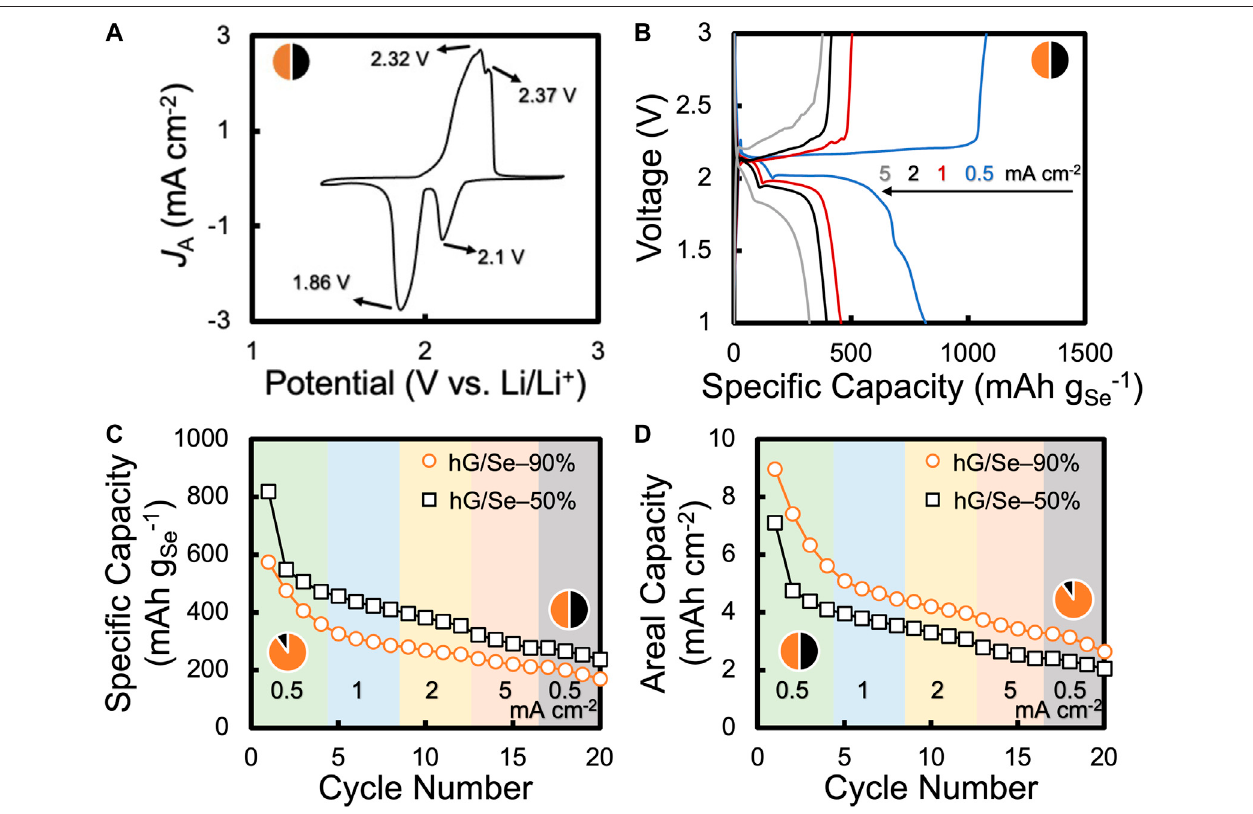
FIGURE3| ElectrochemicalperformanceofLi-SebatterycellswithhG/Secathodes: (A) CVofacellwithahG/Se-50%cathodeat0.05 mV s − 1 ; (B) dischargeand charge curves ofa cell sequentially cycled at 0.5, 1,2, and 5 mA cm − 2 (each for 4cycles); curvesshown arethe fi rst cycle ofeach J A segment, and comparisons ofcells with a hG/Se-50% cathode and a hG/Se-90% cathode in terms of (C) speci fi c capacity and (D) areal capacity.